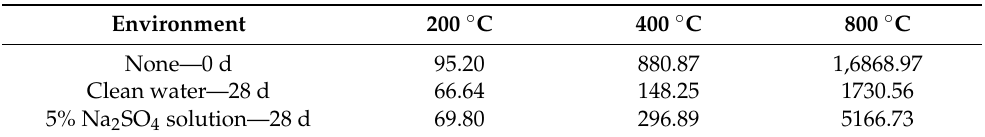
Figure 17. Capillary water absorption curves after exposure to high temperatures and self-healing.